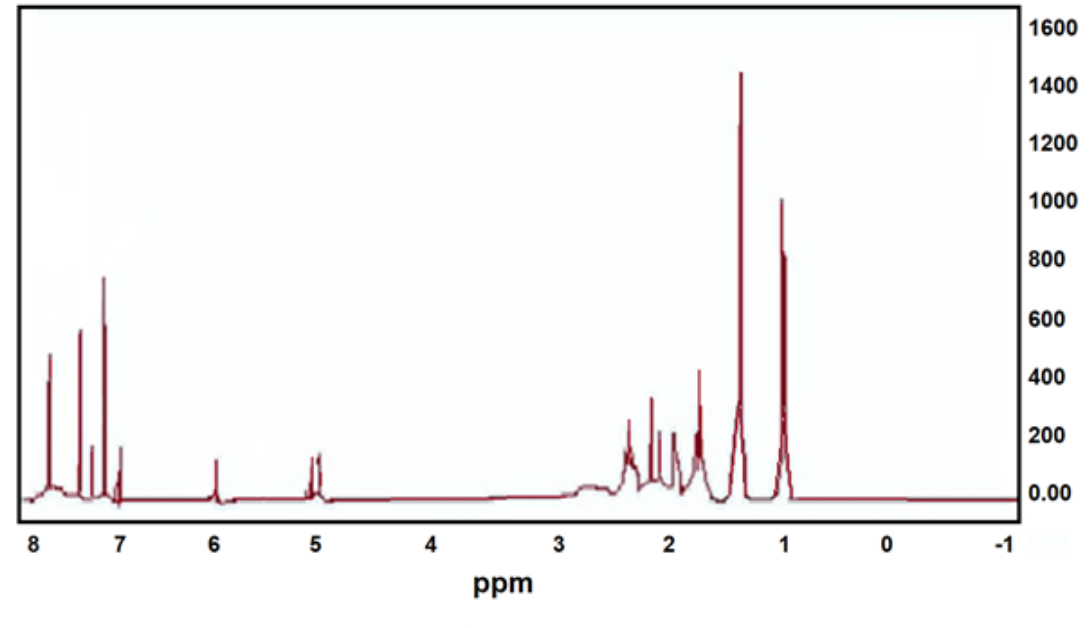
Figure 4. 1 HNMR spectrums of SSP.